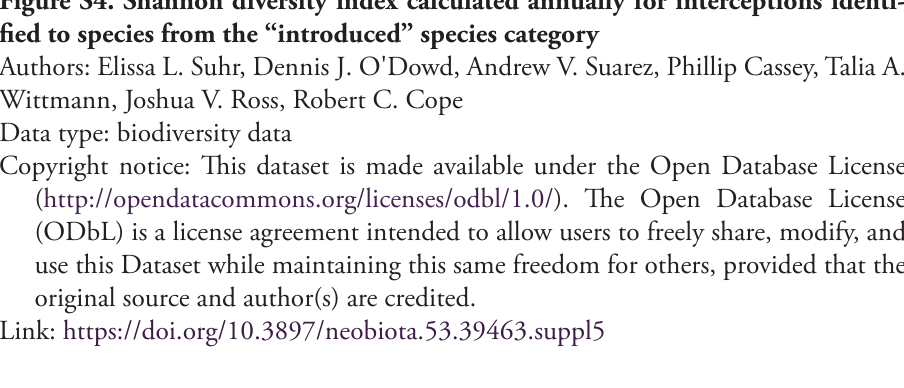
Figure S4. Shannon diversity index calculated annually for interceptions identi- fied to species from the “introduced” species